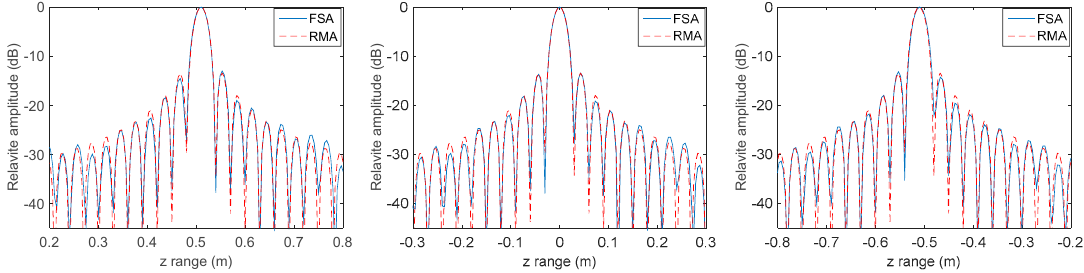
Figure 5. Profile comparisons along x with compensating distance 0 ( left ), 0.51 m ( middle ), and 1.02 m ( right ) by RMA and FSA.